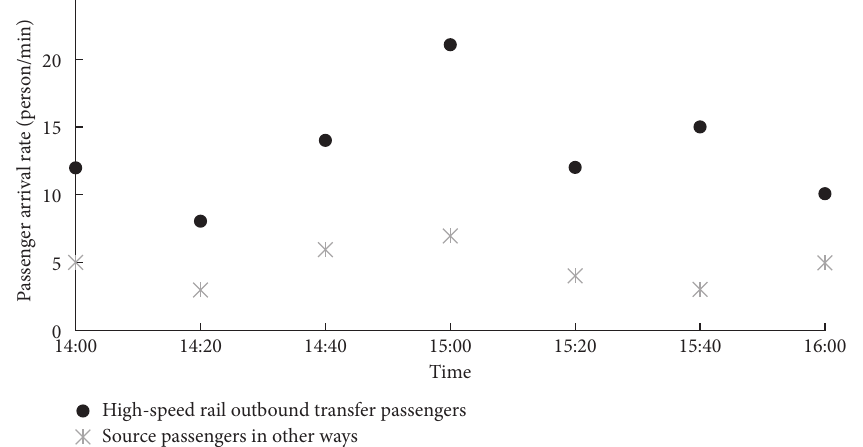
Figure 2: Arrival rate of passengers of different source types at the long-distance passenger